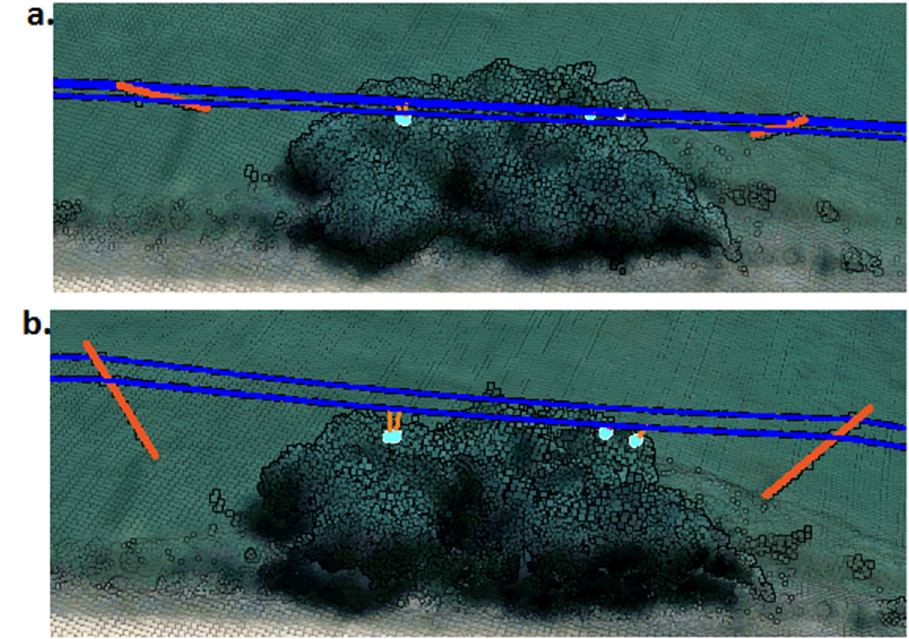
Figure 16. Use of LiDAR data for measurement: ( a ) span view from above; ( b ) span side view.